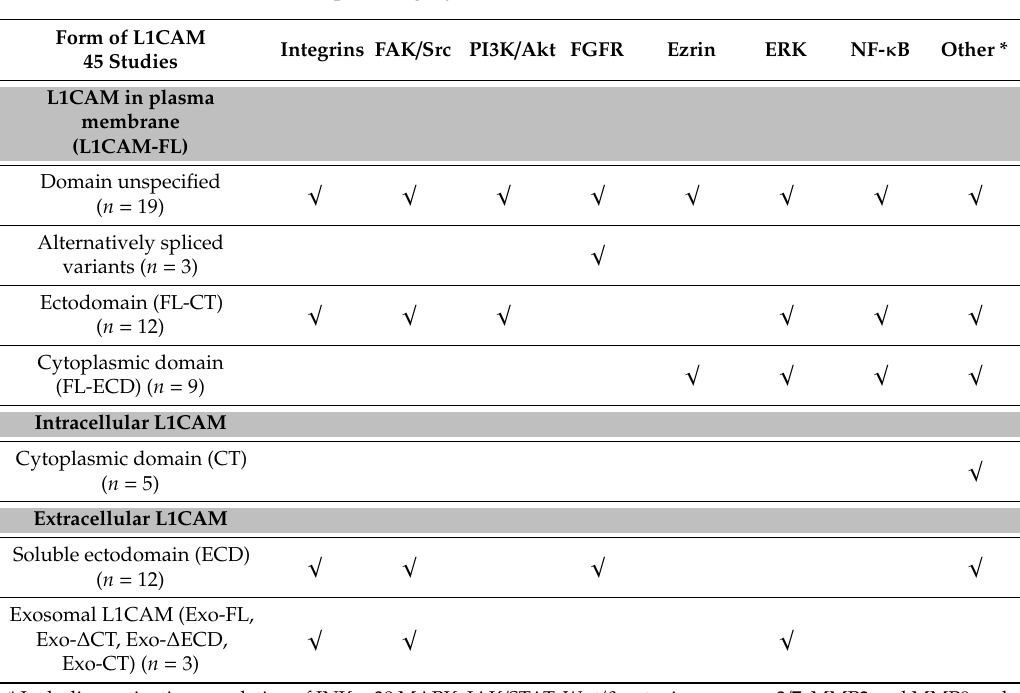
Table 1. Summary of the main signaling pathways involved in domain-specific L1CAM signaling and the number of studies evaluated per